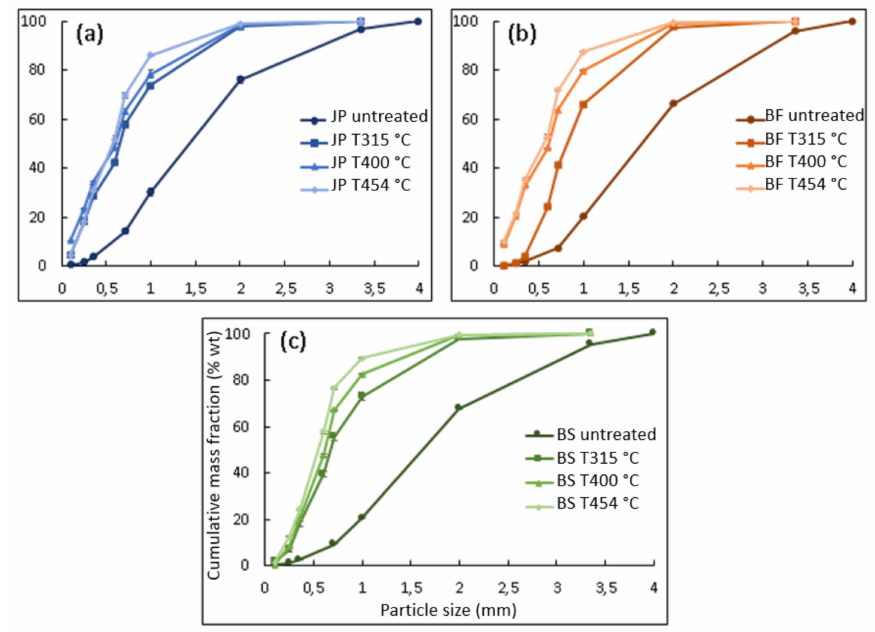
Figure 2. Cumulative particle size distribution for the three types of wood before and after the thermal treatment: ( a ) Jack pine (JP), ( b ) Balsam fir (BF), and ( c ) Black spruce